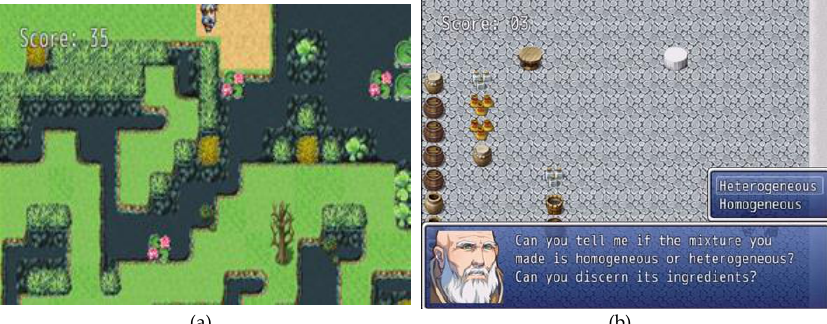
Figure 4. The gameplay prompts the player to explore the virtual world, performing tasks and answering puzzles related to the curriculum and the final goal of the game — to repair the legendary sword and defeat the evil dragon. ( a ) The player learns the concept of mixtures, collecting mud from the swamp. ( b ) The player needs to specify if the mixture he prepared is heterogeneous or homogeneous.